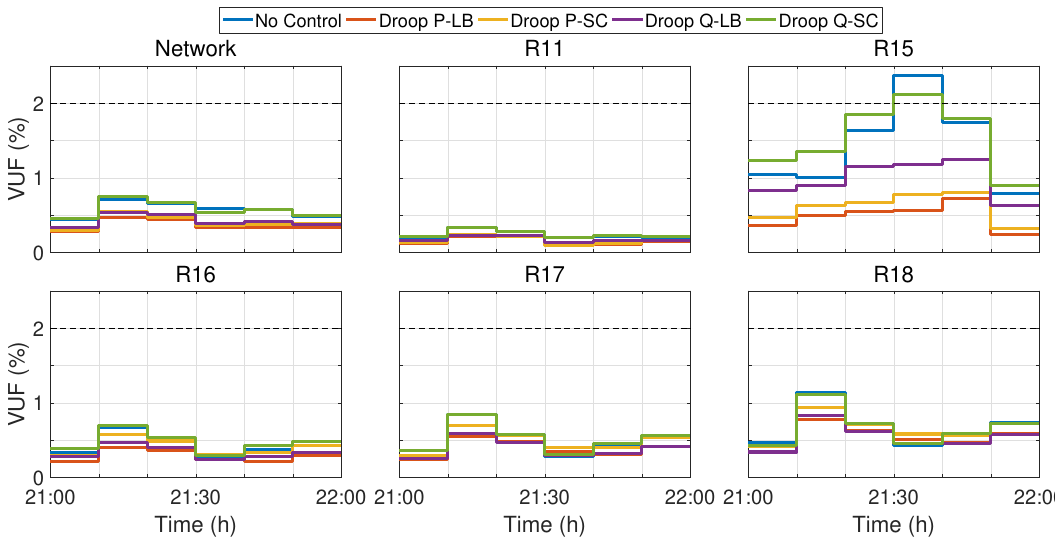
Figure 14. VUF for Scenarios VII, VIII, IX, X, and XI.